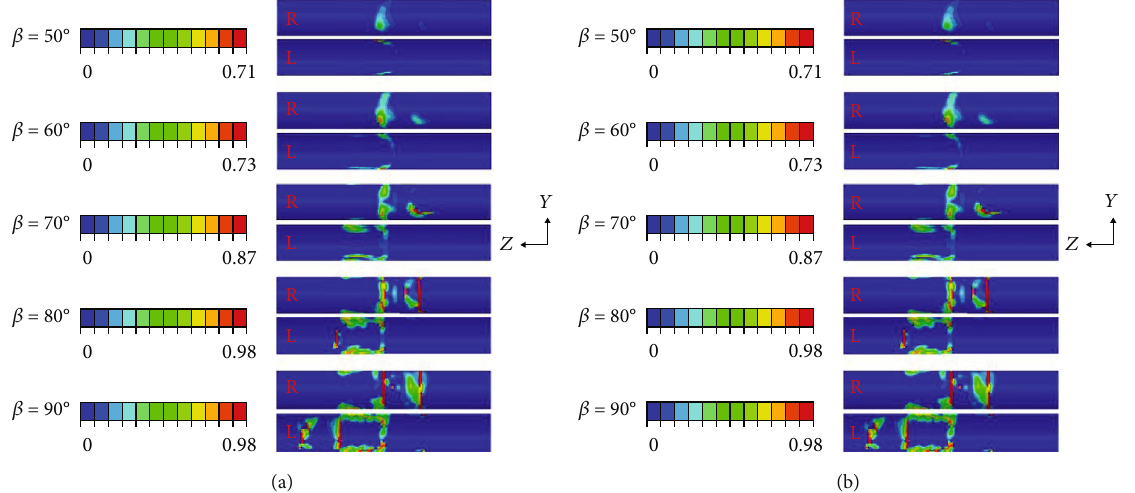
Figure 12: Tensile and compressive damage of secondary lining under di ff erent tunnel-fault intersection angles. (a) Tensile damage. (b) Compressive